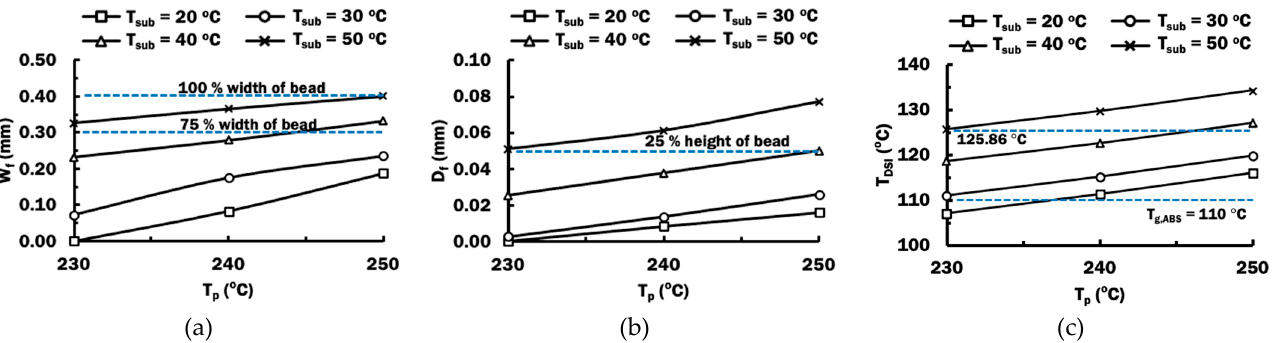
Figure 17. Estimated parameters from heat transfer FEAs for different combinations of printing temperatures and plate heating temperature: ( a ) Fused contact width W f ; ( b ) Depth of rubbery region D f ; ( c ) Deposition temperature at DSI T DSI .